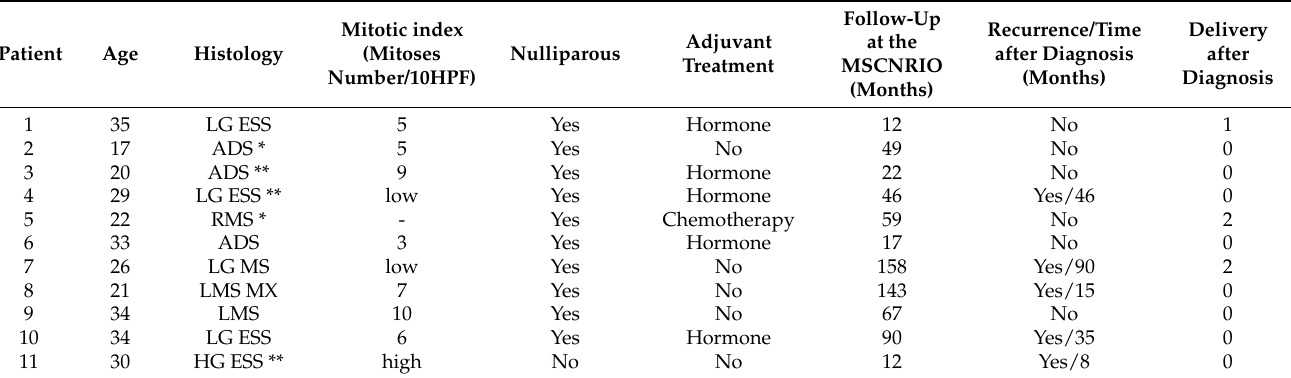
Table 1. Patients’